Question: In one sentence, what is this figure communicating?
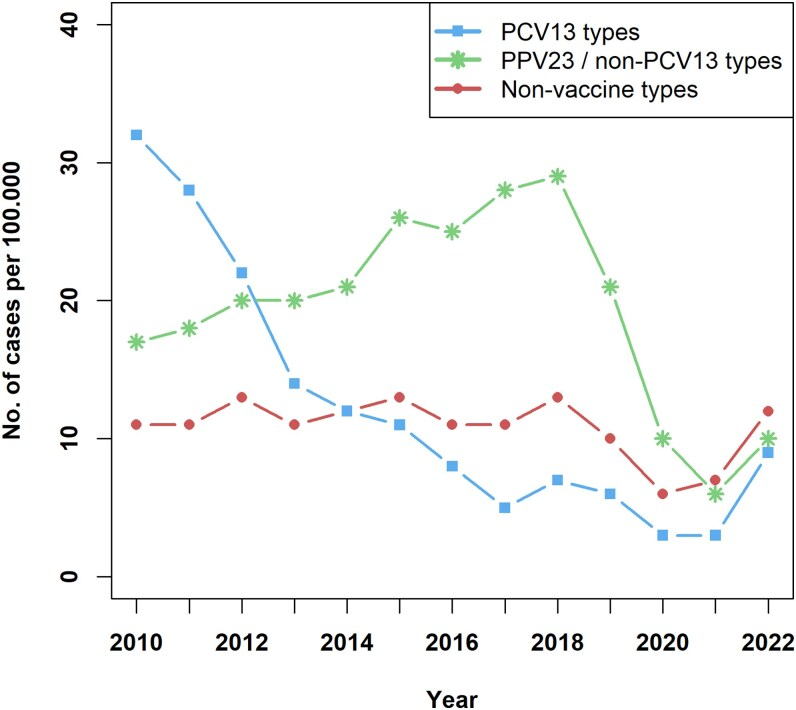
Answer: . Incidence rates of vaccine/nonvaccine type invasive pneumococcal disease during 2010–2022 in adults >65 y.